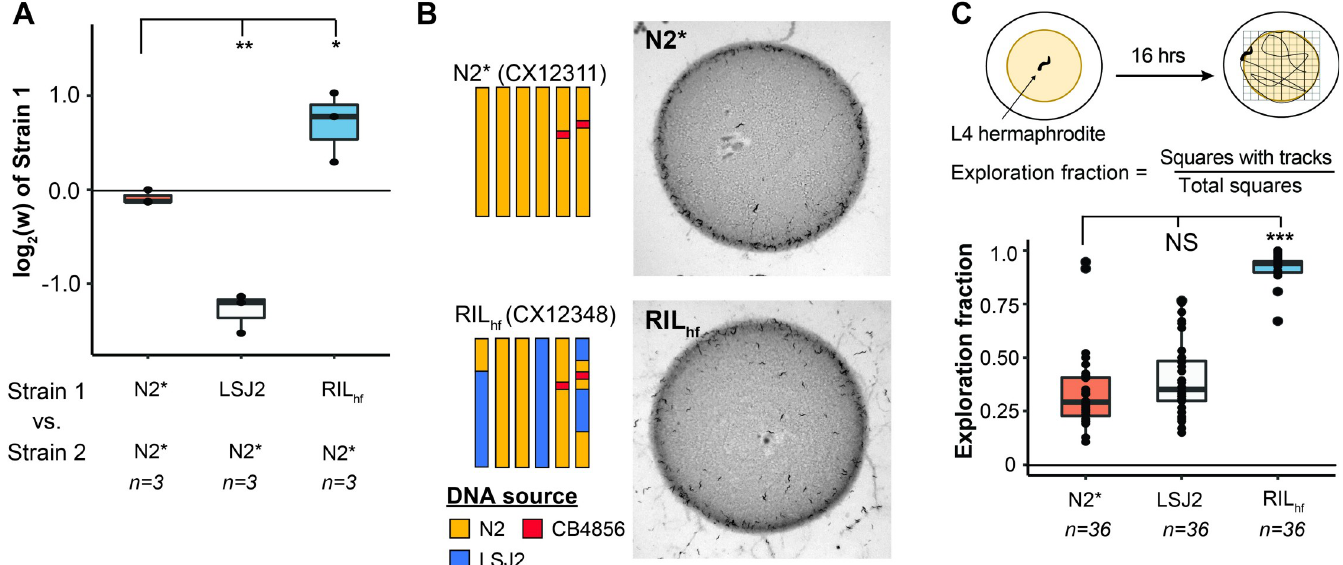
Fig 2. An outlier RIL with higher pairwise fitness and exploration behavior in laboratory conditions. (A) The fitness advantage of RIL hf was verified in an independent experiment ( � : p < 0.05; �� : p < 0.01—one-way ANOVA tests followed by Tukey’s honest significant difference test). (B) Left shows schematic of source DNA of RIL hf (CX12348) from each parental strain. RIL hf contains LSJ2 sequence on chromosome IV and parts of the chromosome I and the chromosome X. RIL hf animals are more likely to be found in the center or outside of the bacterial lawn than at the borders than parental controls (LSJ2 not shown). (C) Exploration behavior differences were quantified by placing a single animal on a plate seeded with a circular lawn. After 16 hours, the amount of the plate that was explored was quantified by counting the number of grid squares with animal tracks within it. Each point represents data from a single animal. The RIL hf explored more of the plate than either parental strain (NS: not significant; ��� : p < 0.001. one-way ANOVA tests followed by Tukey’s honest significant difference test).